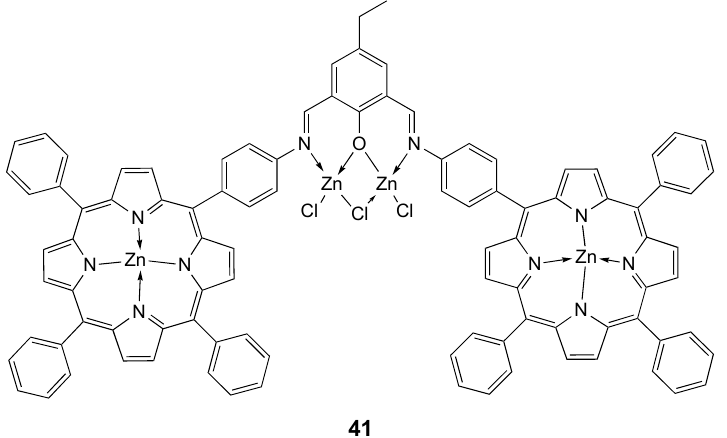
Figure 22. Structure of the zinc complex 41 .